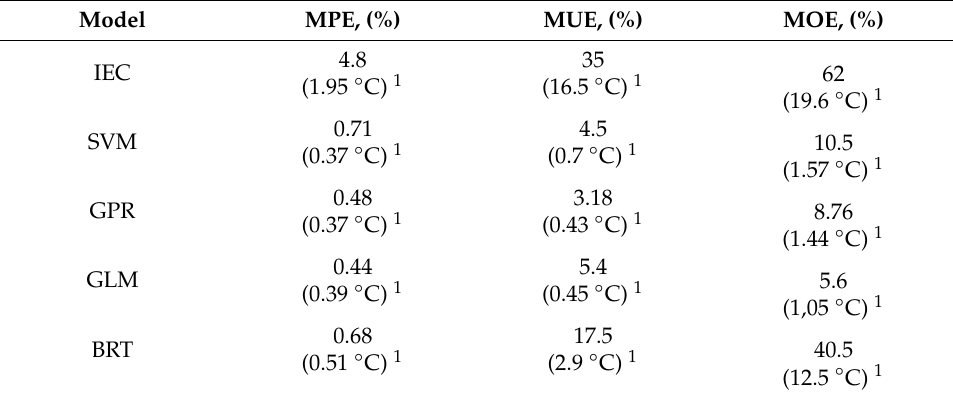
Table 2. Accuracy analysis of the applied